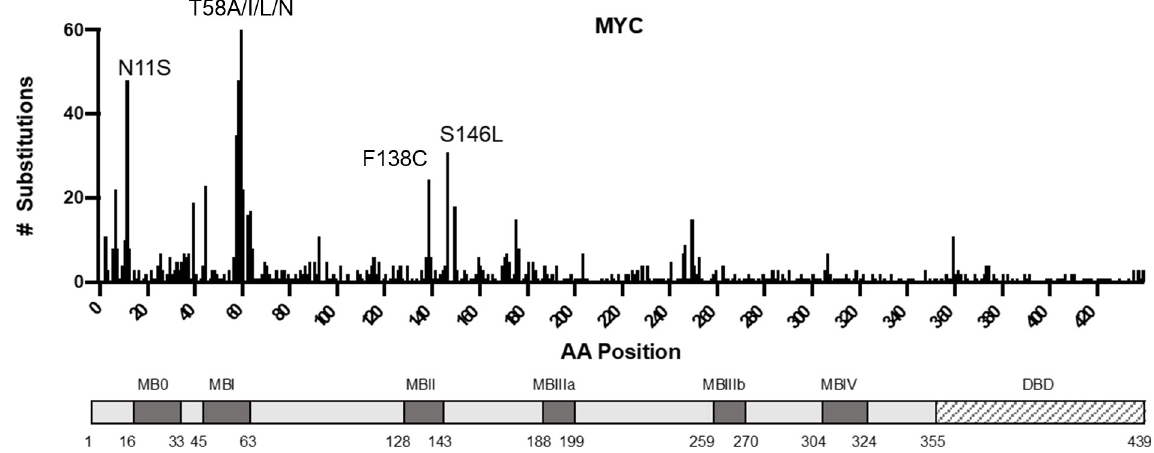
Fig 1. MYC substitutions observed in human cancer. The plot above denotes cancer-associated amino acid substitutions observed in human cancer and their position within conserved domains of MYC. Note that MYC N11S is the result of a germline polymorphism. Data collected from cancer.sanger.ac.uk 26 April